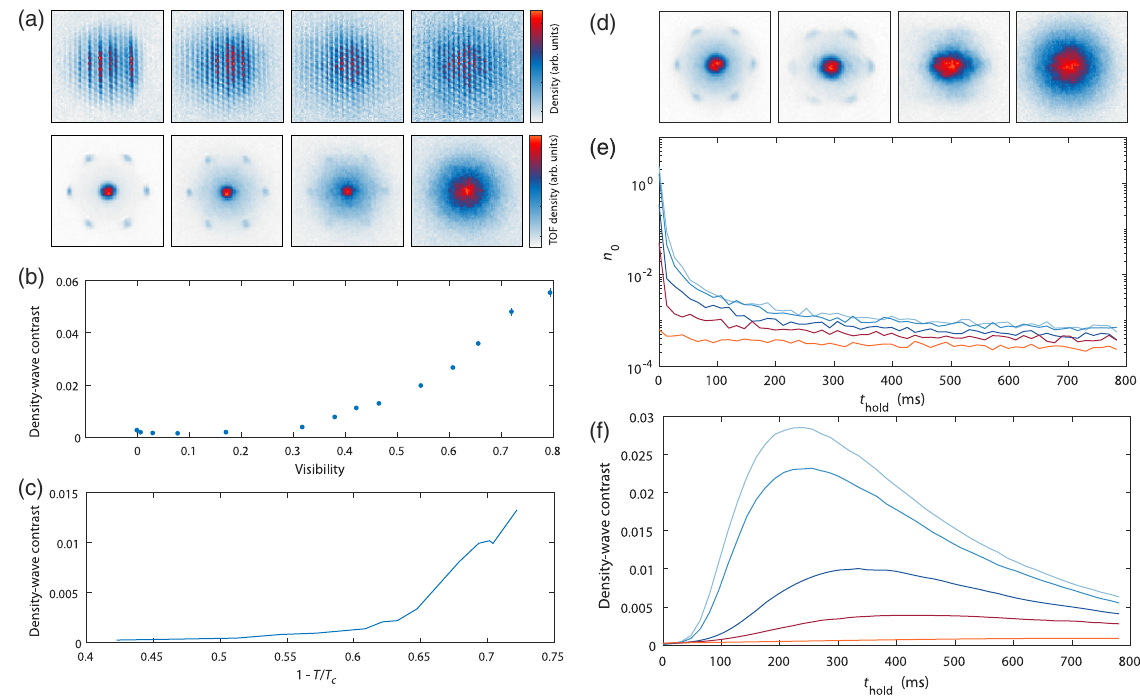
FIG. 12. Influence of coherence on the density-wave formation. (a) Density-wave pattern for different initial temperatures of the BEC before the quench into the tilted system (upper row). The coherence of the initial system is evidenced by the visibility of the Bragg peaks in a time-of-flight (TOF) measurement before the quench (lower row). The temperature is increased deliberately by a hold time in the lattice of (from left to right) (0.1, 750, 1200, 1800) ms leading to a visibility of (0.79, 0.42, 0.17, 0.006). (b) Density-wave order as a function of the Bragg-peak visibility in the experiment for a hold time of 100 ms and an energy offset of Δ ¼ h × 1 . 4 kHz. All error bars correspond to the 68% confidence interval. (c) Simulation of the density-wave order for the experimental parameters, plotted as a function of 1 − T=T , where T is the critical temperature of a noninteracting gas. (d) TOF measurements for (0.1, 1.1, 2.1, 1200) ms c c (from left to right) hold time after the quench and Δ ¼ h × 1 . 1 kHz. The hold times are approximately stroboscopic with respect to the Bloch oscillation period. (e) The condensate density n 0 versus time in the numerical simulation for different temperatures reproduces the rapid loss of coherence and shows that a very small coherent fraction remains, which is not experimentally detectable. (f) The density- wave order for the parameters in (e) shows that this residual coherence is crucial for the density-wave formation. The different colors ¼ 0 . 28 , 0.32, 0.39, 0.45, and 0.53 (top to stand for different initial temperatures of T=T c